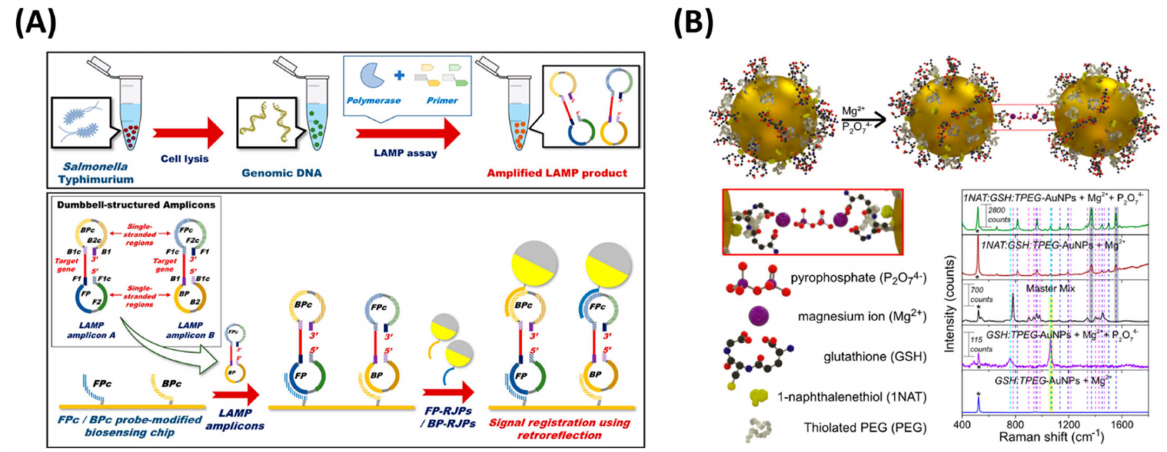
Figure 5. Optical detection methods of LAMP amplicons. ( A ) Schematic representation of retroreflec- tive Janus particle − based biosensor. ( B ) Detection of LAMP amplified DNA using SERS. Reproduced with permission from references [96,101]. Copyright 2018 American Chemical Society, 2020